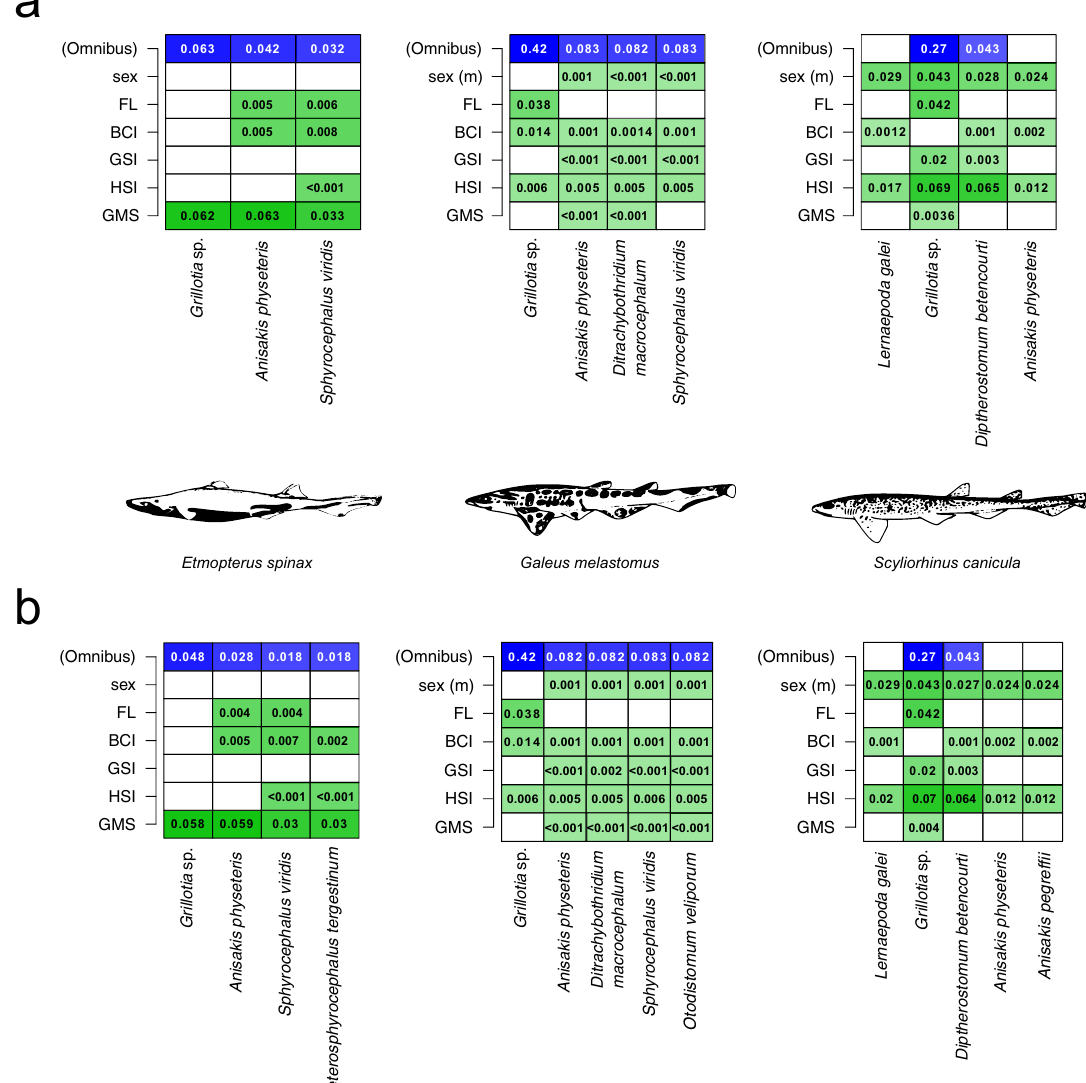
Figure 1. Heatmap of the effect size showing the pairwise effect of morphological (FL and BCI) and physiological (age, sex, GMS, GSI, and HSI) predictors (conditional on the rest of the predictors) on each individual parasites considering the whole infracommunity ( a ) and by removing extremely rare parasite species ( b , i.e., those parasites present with a single individual in a single specimen). Omnibus (blue cells) refers to the effect size of the entire design matrix on each outcome, while numbers in green cells the pairwise effect size (i.e., the effect of each predictor on each outcome variable, conditional on the rest of the predictors). Sharks in the figure have been redrawn from Compagno 80,81 and downloaded from https:// fishb ase. org under a Creative Commons License—CC BY-NC